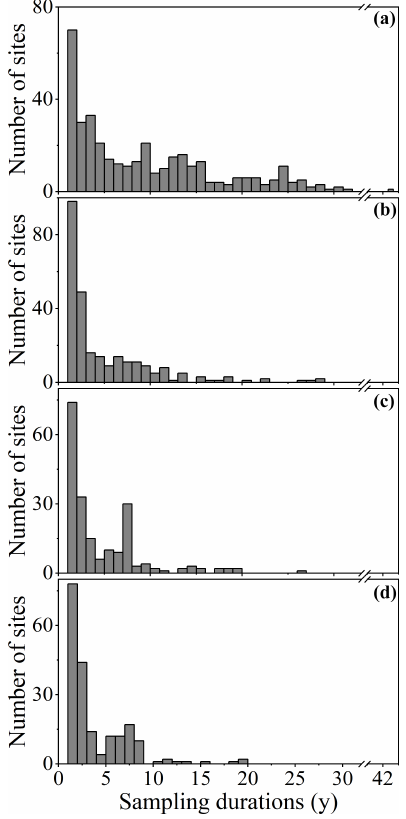
Figure 3. Histogram of sampling durations of (a) 7 Be concen- tration, (b) 210 Pb concentration, (c) 7 Be depositional flux, and (d) 210 Pb depositional flux. For those sites with multiple datasets, we added the sampling duration together, after deducting the over- lapping period (if there was one). Note that the 7 Be and 210 Pb de- positional flux data plotted here refer to those obtained using rain